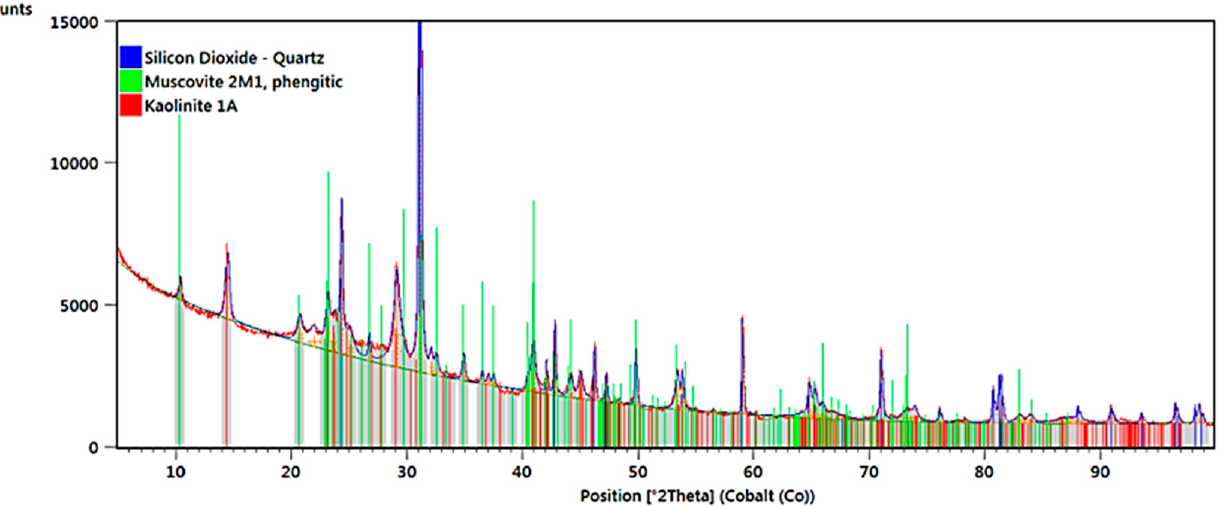
Figure 2. Claystone samples: left—macroscopic image; right—micro-photos in thin plates; crossed polarizers, magnification 100 × .